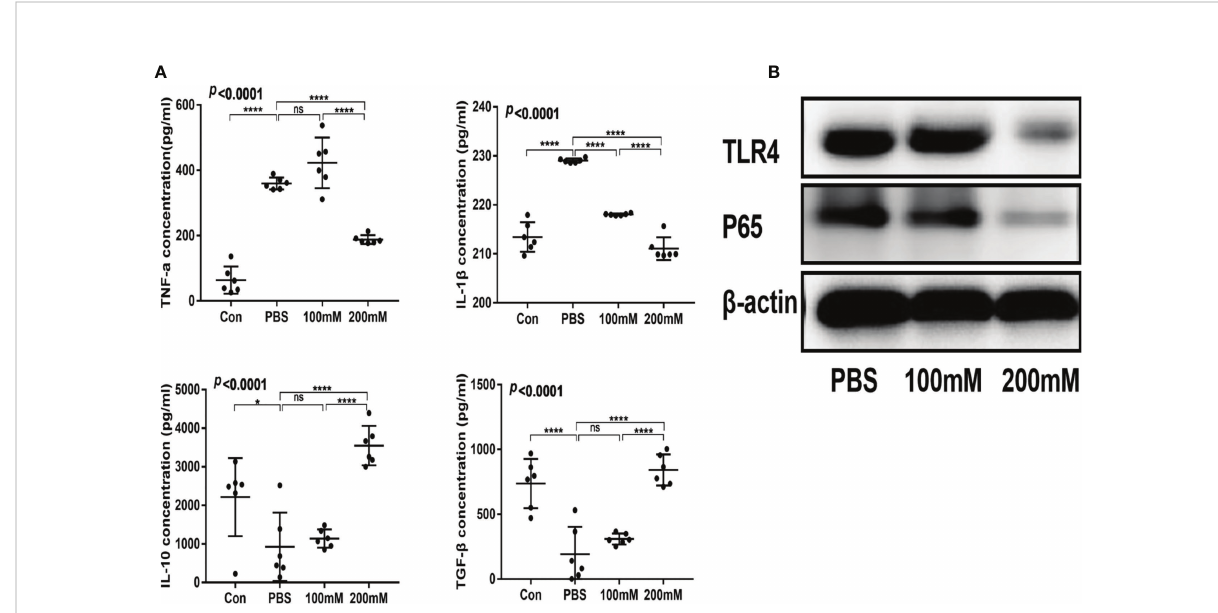
FIGURE 4 Lactic acid alleviated intestinal in fl ammation in mice with colitis. (A) Serum levels of in fl ammatory factors in different groups (n = 6). (B) Western blotting analysis of in fl ammatory signals TLR4 and P65 in colon tissues of different